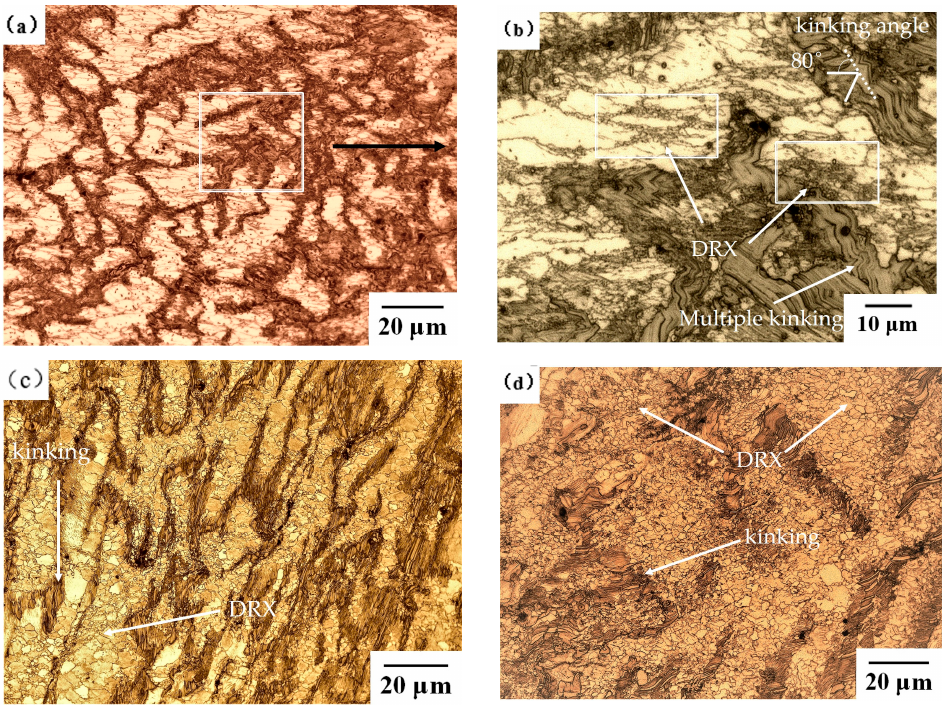
Figure 3. OM images exhibiting DRX and kinking within deformed alloys at a strain rate of 0.001 s − 1 at several temperatures: ( a , b ) 300 ℃ ; ( c ) 350 ℃ ; and ( d ) 400 ℃ .